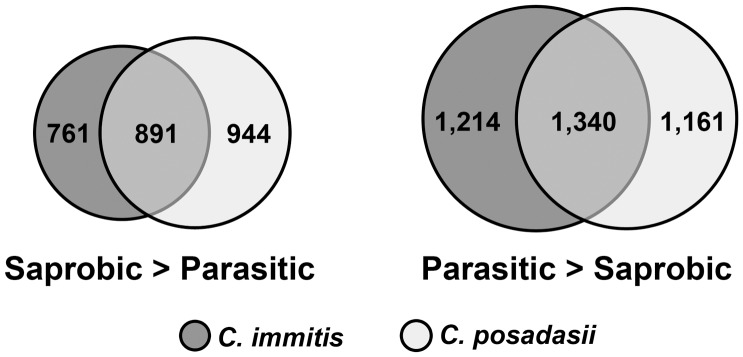
Differentially expressed genes in C. immitis and C. posadasii.Venn diagrams showing the number of genes commonly differentially regulated in the saprobic vs. parasitic growth phases of C. immitis and C. posadasii.